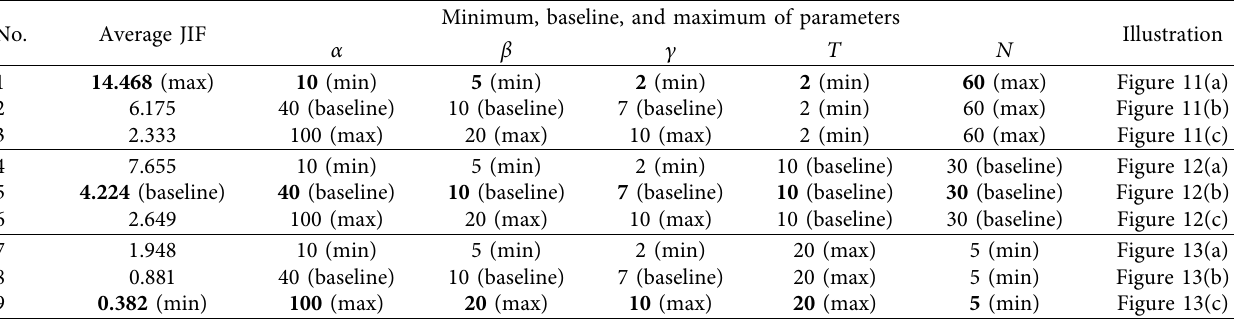
Figure 13: Variation of the JIF within 13 years in 100 Monte Carlo simulations with T Table 2: Average JIF under different parameter combination